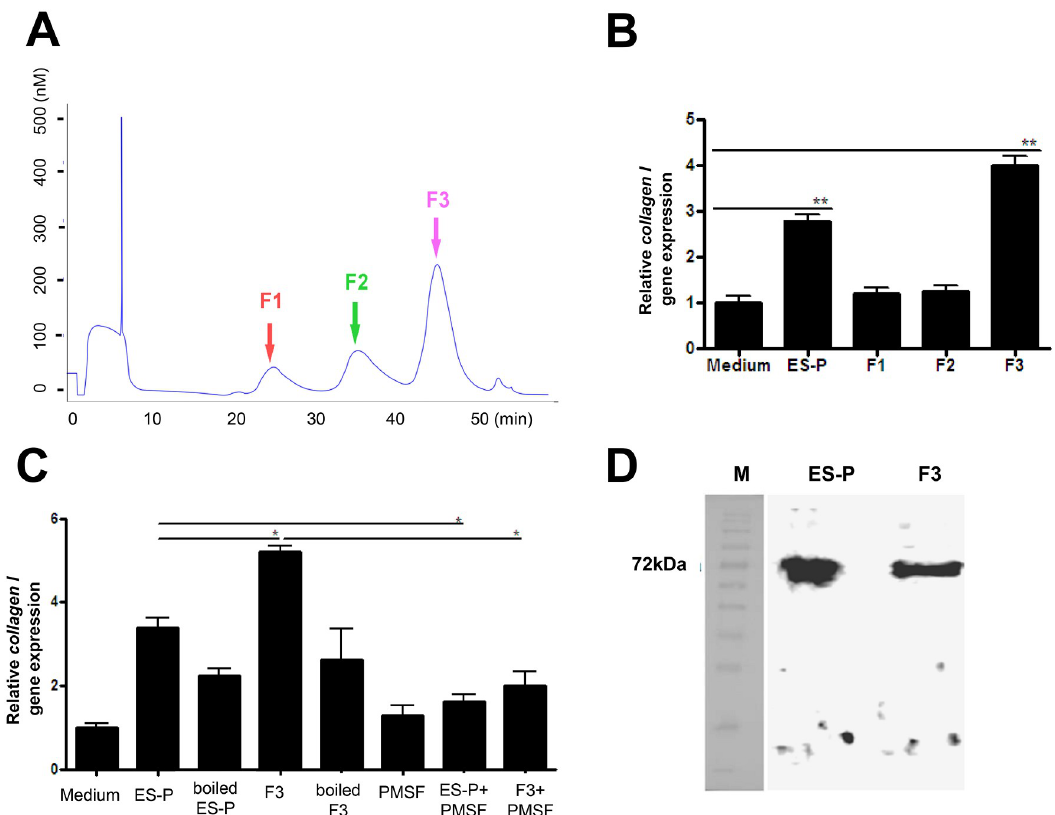
Fig 2. Fractionation of the ES-P by chromatography and type I collagen expression analysis. (A) Chromatograhic profile of ES-P conducted by gel filtration chromatography. (B) Type I collagen gene expression levels were compared after ES-P or fractionation treatment. The collagen gene expression levels of each group were normalized with medium group. (Medium; cell culture medium, ES-P; T . spiralis ES proteins, F1; F1 fraction, F2; F2 fraction, F3; F3 fraction). (C) To confirm the collagen inducing ability was related with protease activity. (Boiled ES-P; treatment with T . spiralis ES protein boiled, boiled-F3; treatment with F3 boiled for 10 min at 90˚C, PMSF; only PMSF treatment, ES-P+PMSF; T . spiralis ES proteins and PMSF treatment, F3+PMSF; F3 fraction and PMSF treatment). (D) Western blot analysis of ES-P and F3 with polyclonal α -F3 antibody. ( � ; P < 0.05, �� ; P < 0.01, these were representative results from three independent